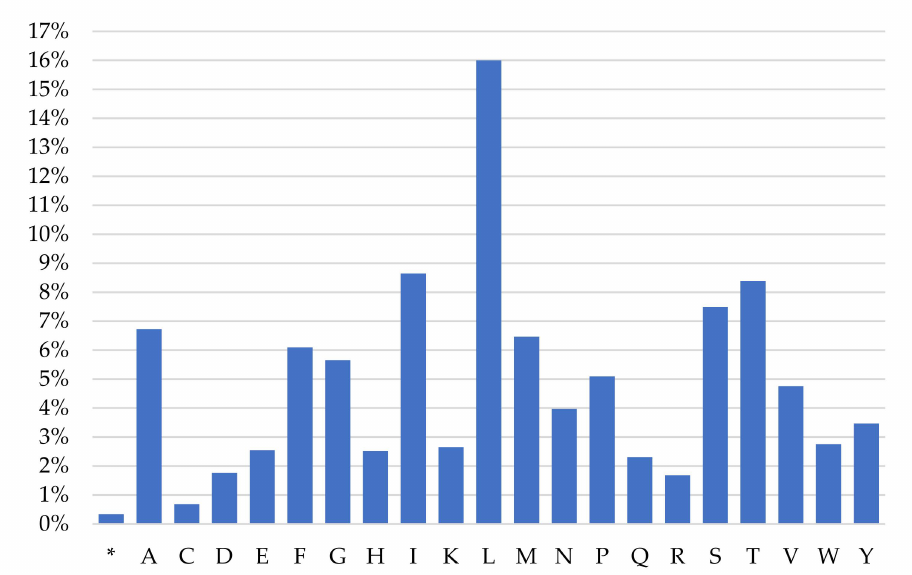
Figure 5. Codon frequency for individual amino acids in the mitochondrial protein-coding genes of European mink (presumed polyadenylated incomplete termination codons included [31]; * termina- tion